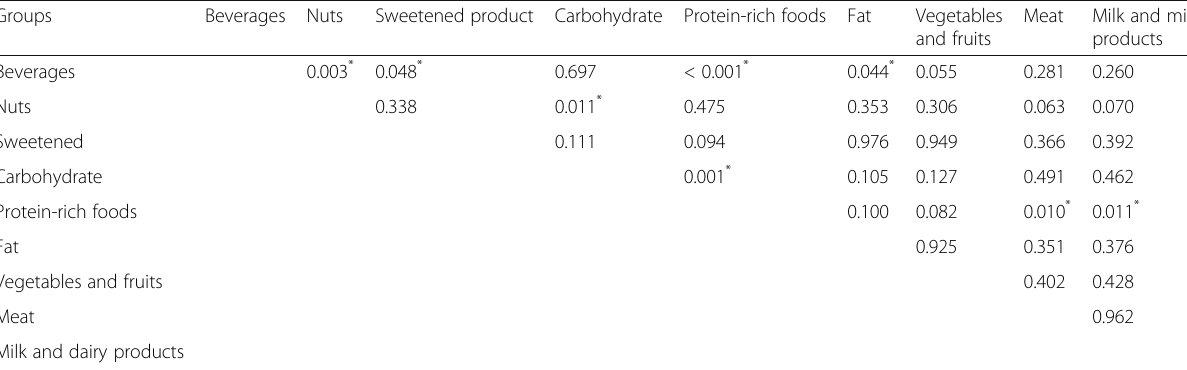
Table 3 Significance and non-significance of differences between nine studied groups according to selenium content